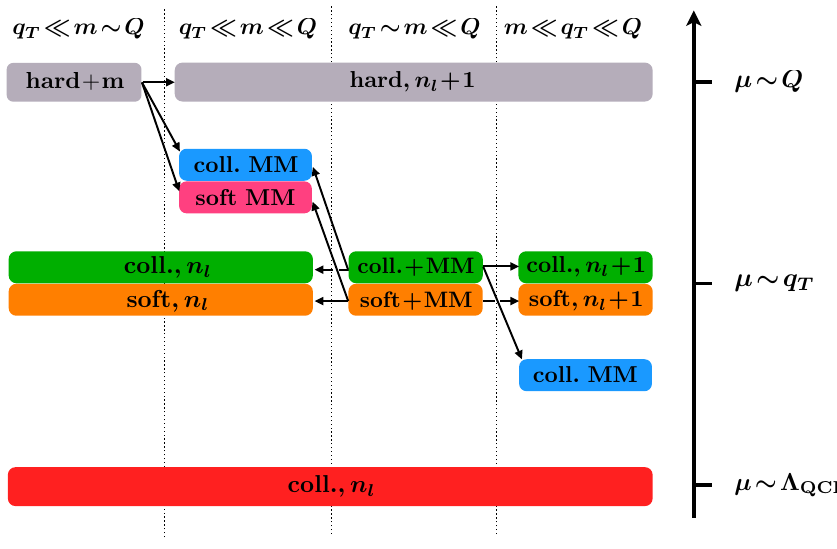
Q for di(cid:11)erent hierarchies between the (cid:28)